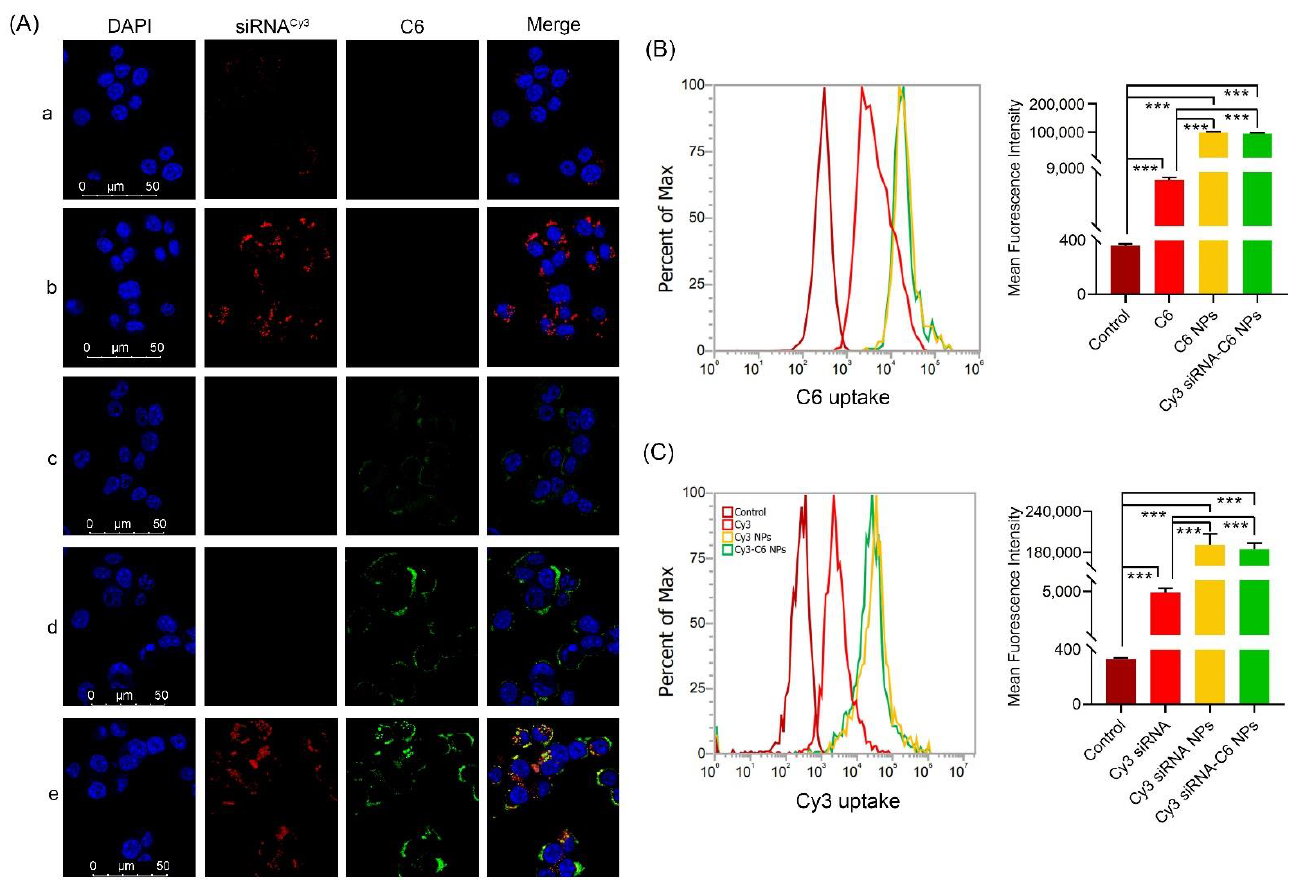
Figure 4. Cellular uptake of C6 or Cy3 siRNA in different formulations. 4T1 cells were analyzed after 4 h of incubation at the final concentrations of different NPs (C6 content 100 ng/mL, Cy3 siRNA 50 nM, N/P = 30 and C/N = 1/5). ( A ) CLSM images of cellular uptake of C6-siRNA Cy3 NPs. (a) siRNA Cy3 ; (b) siRNA Cy3 NPs; (c) ITZ; (d) ITZ NPs; and (e) siRNA Cy3 -ITZ NPs. For each column, from left to right: nuclei were stained by DAPI (blue); C6 fluorescence in cells (green); Cy3 signal in cells (red); merged with nucleus, C6 and siRNA Cy3 . Scale bar = 50 µm. ( B ) Quantitative analyses of C6 uptake by flow cytometry. ( C ) Quantitative analyses of Cy3 siRNA uptake by flow cytometry. *** p < 0.001 as compared with C6 or Cy3 siRNA ( n = 3).